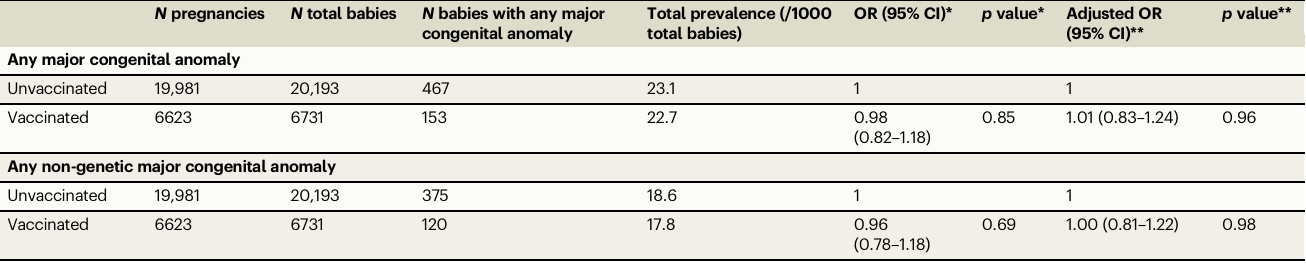
Table 3 | Odds ratios for the association between COVID-19 vaccination and major congenital anomalies among babies reaching at least 12 weeks gestation, calculated using conditional logistic regression models N